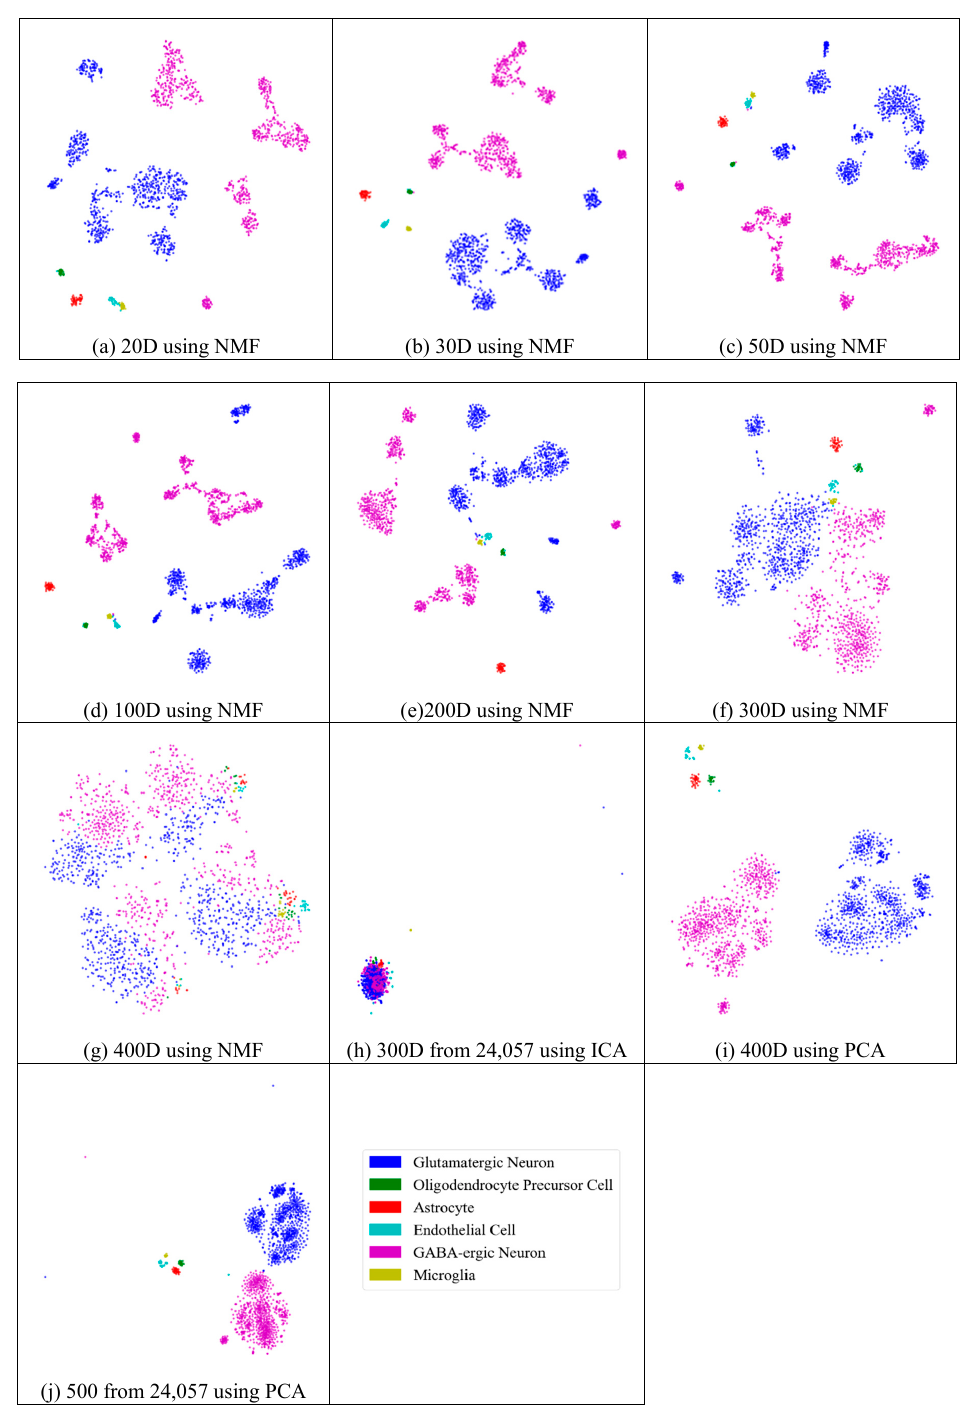
Figure 10. Comparison of different feature spaces and different extraction strategies on the mouse visual cortex data. ( a ) 20 dimensional feature space (20D) from 500 genes using the NMF model. ( b ) 30 dimensional feature space (30D) from 500 genes using the NMF model. ( c ) 50 dimensional feature space (50D) from 500 genes using the NMF model. ( d ) 100 dimensional feature space (100D) from 500 genes using the NMF model. ( e ) 200 dimensional feature space (200D) from 500 genes using the NMF model. ( f ) 300 dimensional feature space (300D) from 500 genes using the NMF model. ( g ) 400 dimensional feature space (400D) from 500 genes using the NMF model. ( h ) 300 dimensional feature space (300D) from 24,057 genes using the ICA model. ( i ) 400 dimensional feature space (400D) from 500 genes using the PCA model. ( j ) 500 dimensional feature space (500D) from 24,057 genes using the PCA model.